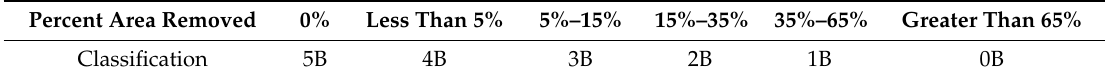
Table 1. Classification of adhesion test